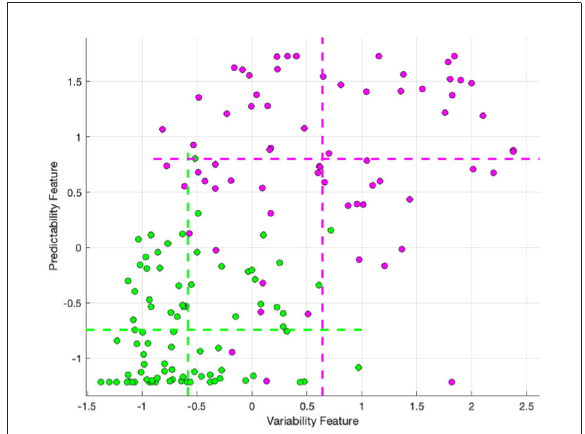
FIGURE4 The variability and lack of predictability feature values for cluster 2 (Green) and cluster 1 (Purple), with the mean of each feature for each cluster marked with dashed